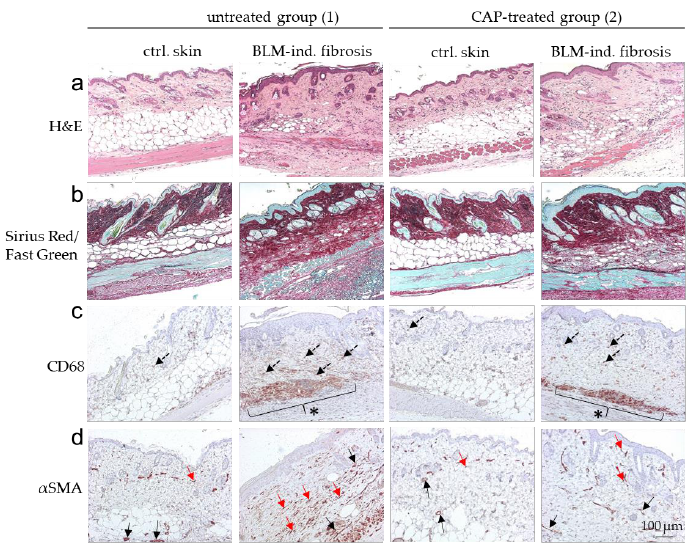
Figure 6. Histological overview of the BLM-induced scleroderma model after CAP treatment. Representative images of ( a ) H&E, ( b ) Sirius Red/Fast Green, ( c ) CD68- and ( d ) αSMA-stained sections of untreated (group 1) and CAP-treated (group 2) mice. Each group contains skin sections treated with DPBS (ctrl. skin) and bleomycin (BLM-ind. fibrosis) col- lected from two separate areas on the same murine back. Dotted arrows in ( c ) indicate CD68-positively stained macro- phages elevated in BLM-induced fibrosis and a reduction in dermal tissue after CAP treatment. * in ( c ) indicates an increase in capillary macrophages in BLM-induced fibrosis in comparison to control skin. This increase of vascular macrophages was not included in the evaluation of CD68 staining. αSMA-stained myofibroblasts (red arrows) in ( d ) are strongly in- duced in BLM-induced fibrosis. Vessel structures are also αSMA-stained (black arrows) in ( d ) and were excluded in the evaluation. Scale bar: 100 µm.